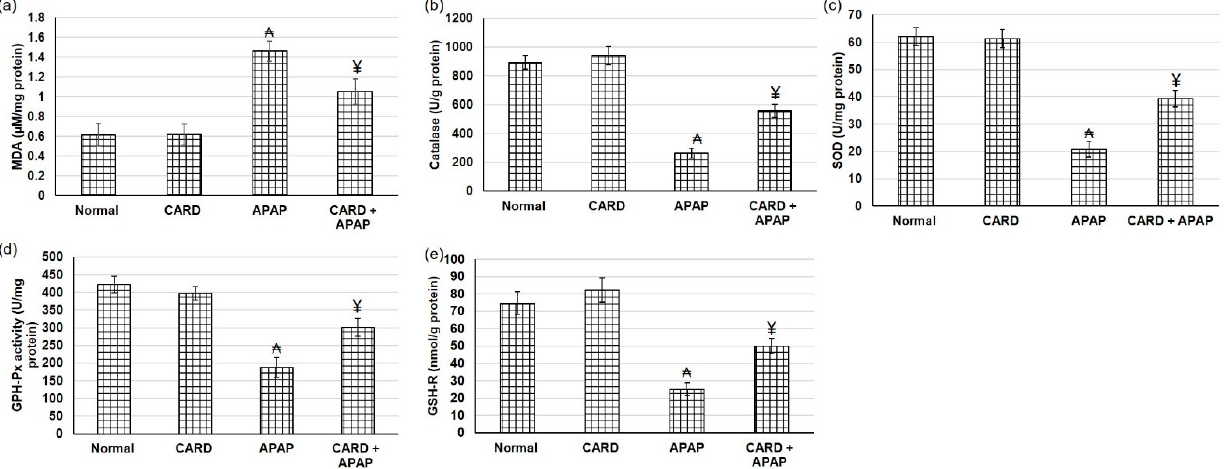
Figure 5. Effects of CARD aqueous extract (200 mg/kg) administration for 15 days prior to APAP administration (300 mg/kg) on lipid peroxidation, including ( a ) MDA content and antioxidant enzymes activities, including ( b ) catalase, ( c ) superoxide dismutase (SOD), ( d ) glutathione peroxidase (GSH-Px) and ( e ) glutathione reductase (GSH-R) activities, respectively, in APAP-induced acute hepatic failure in mice. All values are stated as mean ± SD. ₳ designates statistically significant compared to the normal group, and ¥ designates statistically significant compared to the APAP group ( p < 0.05) using one-way ANOVA followed by Tukey’s post hoc test.